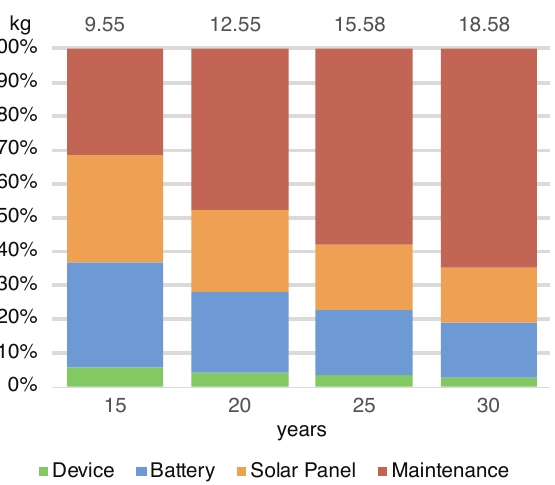
Figure 3. Energy impact of the IoT solution considering 35 devices in different lifespan scenarios.